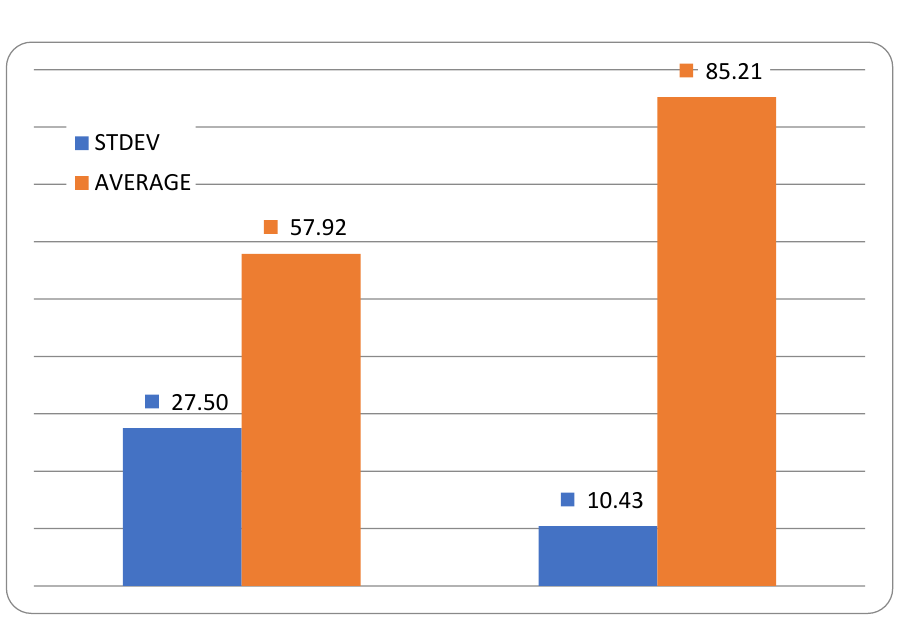
Figure 11. Comparison between use our proposed weighted DTW and the original DTW.